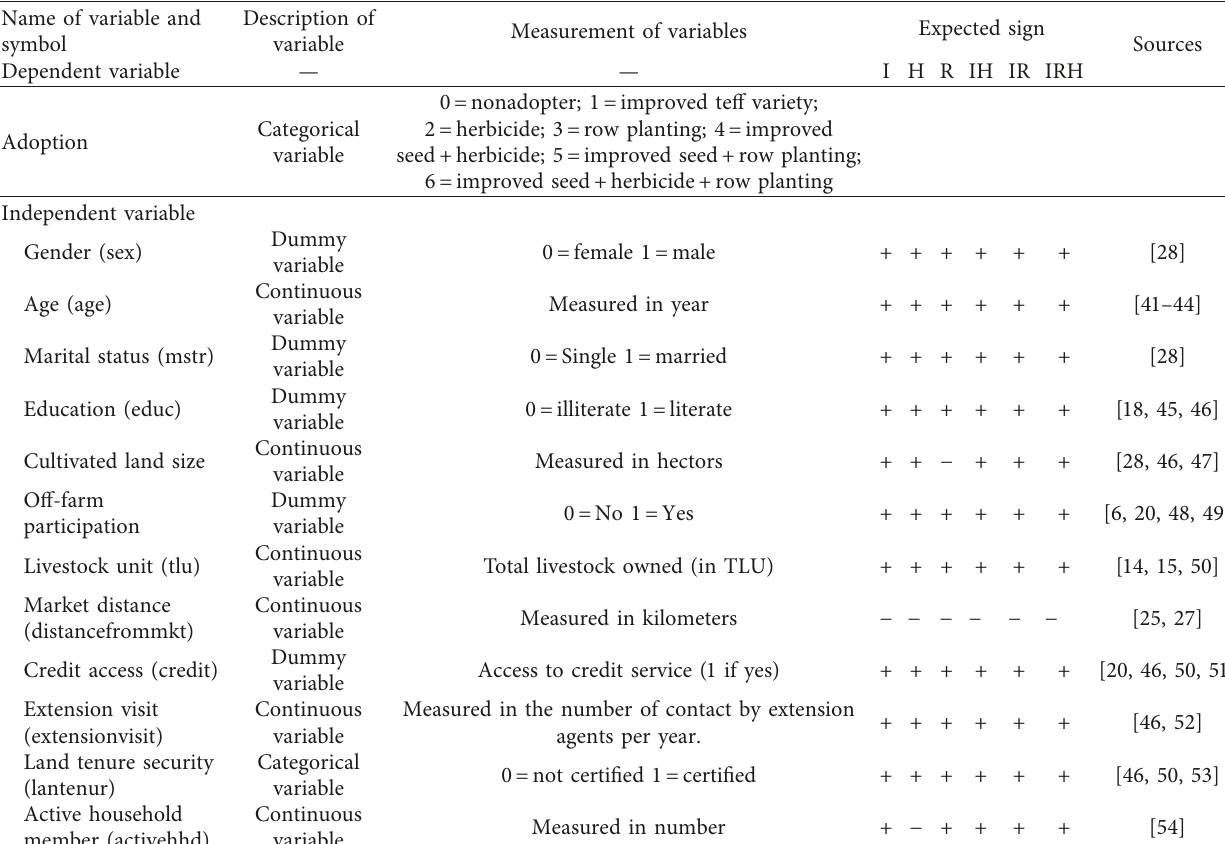
Table 2: Measurement, description of variables, and expected